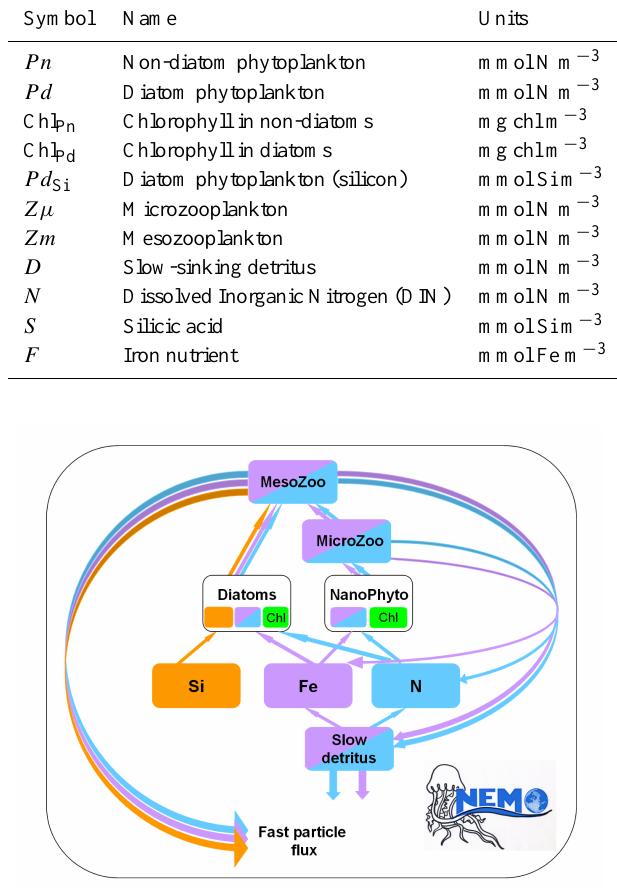
Fig. 1. Schematic diagram of the MEDUSA ecosystem